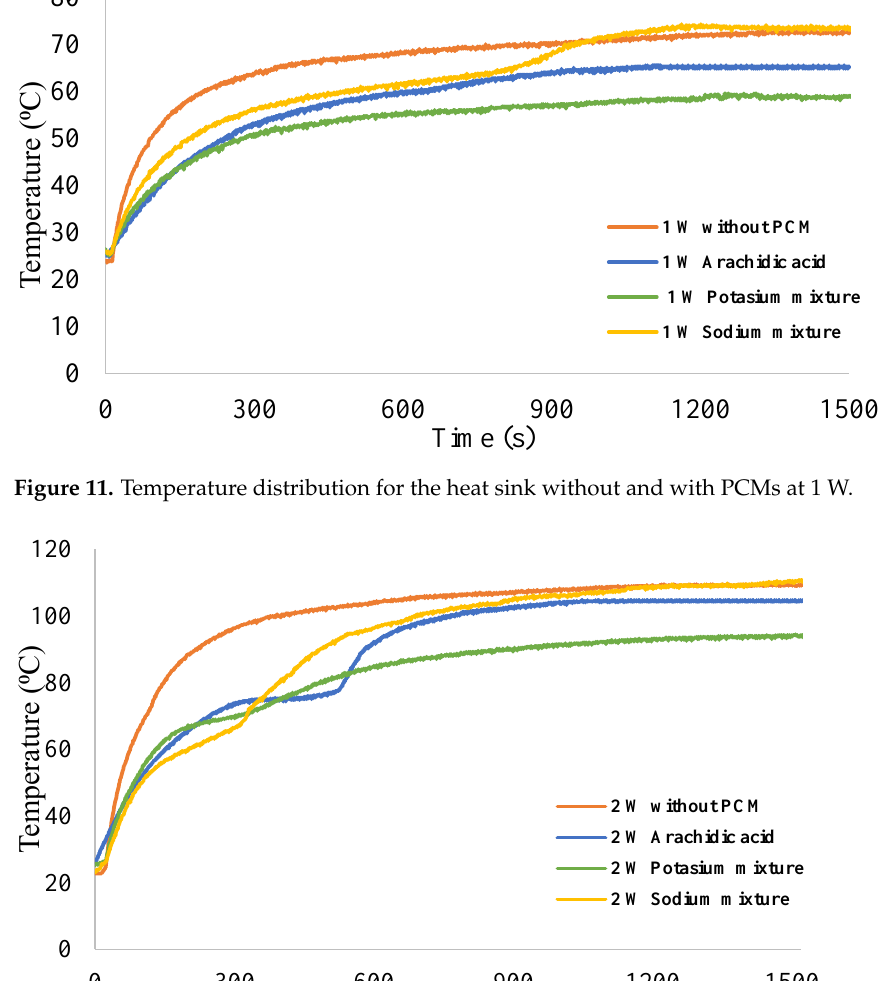
Figure 10. Temperature distribution for the heat sink without and with PCMs at 0.5 W. As for the case at 1 W, the temperature profile for the heat sink without PCM and the heat sink using Arachidic acid and potassium mixture as the PCM continued to increase until reaching a steady-state temperature, while for the sodium mixture, the PCM melted, and the temperature decreased during melting, delaying the steady-state time by 320 s. proximately the same. For the cases of Arachidic acid and potassium mixture, they did not melt, but the steady-state temperature (59 °C) was lower than the case without PCM (72 °C).